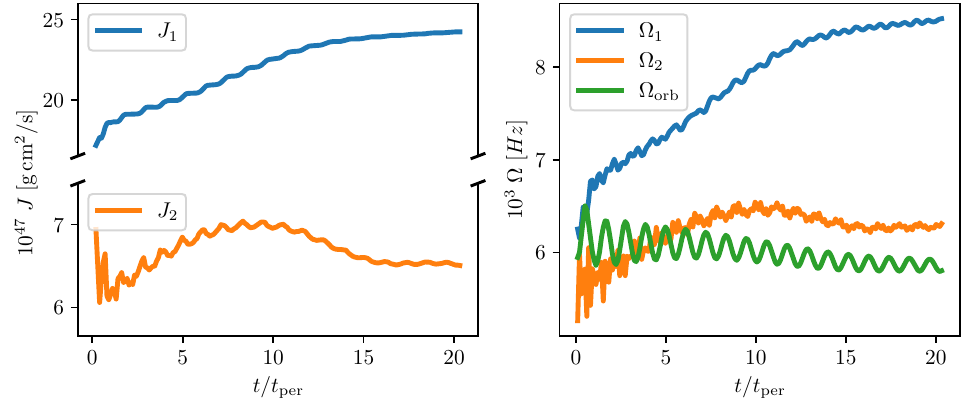
Figure 6. Relative angular momentum of two stars ( left panel ) and their angular rotational velocities together with the orbital angular velocity ( right panel ) as functions of